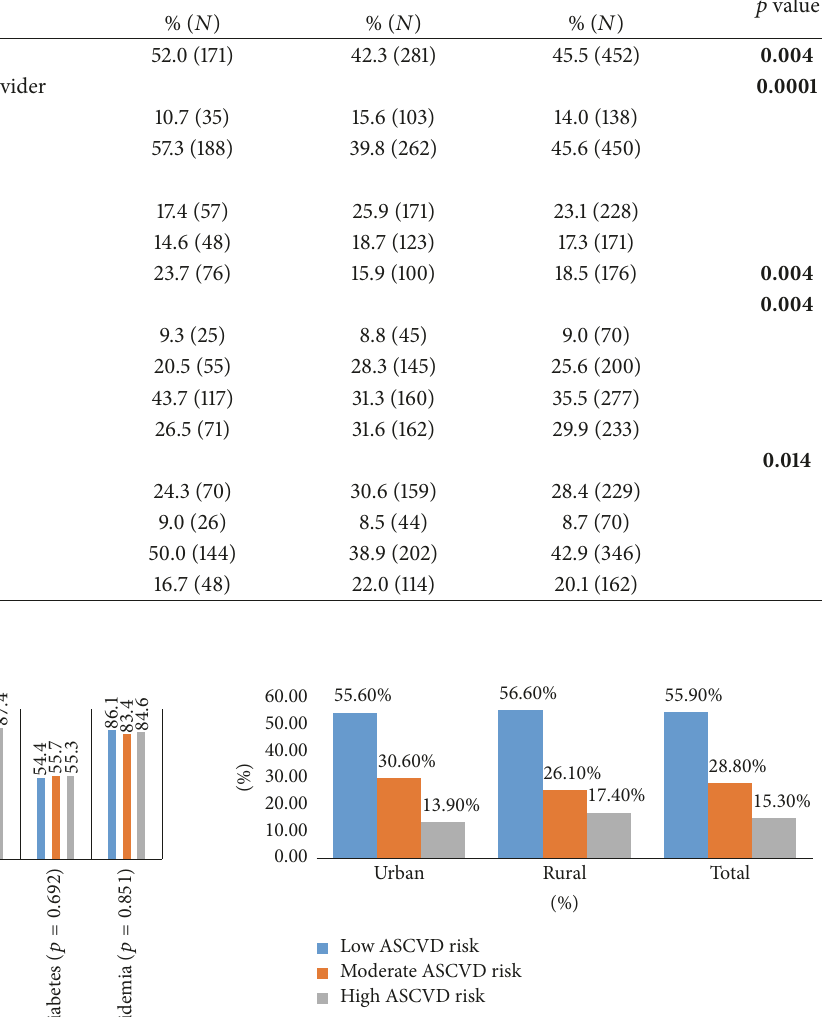
Figure 3: ASCVD risk in the study